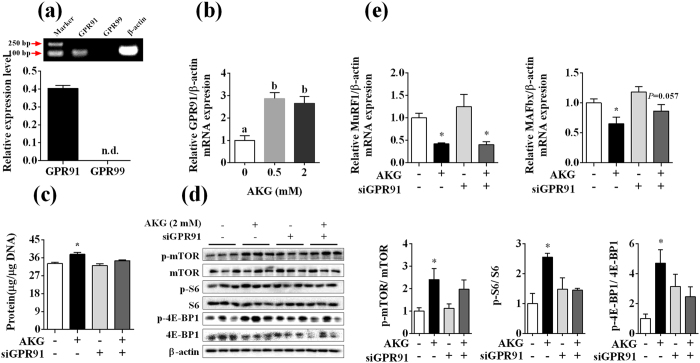
Role of GPR91 in AKG-induced protein synthesis.C2C12 cells were transfected with vector or siGPR91. C2C12 cells were cultured for 6 d in a differentiation medium and then treated with AKG (2 mM) for 48 h. (a) The expression of GPR91 and GPR99 in C2C12 cells. (b) AKG up-regulated the mRNA expression of GPR91. (c) Total protein levels in C2C12 myotubes. (d) The phosphorylation levels of mTOR, S6, and 4E-BP1 measured by Western blot. (e) The mRNA expression of MuRF1 and MAFbx by qPCR. Data are presented as mean ± SEM. Different superscripts “a”/“b” represent significant differences between groups (P < 0.05), and *means P < 0.05 compared with the control. β-actin served as a housekeeping gene control. n.d. not detectable.